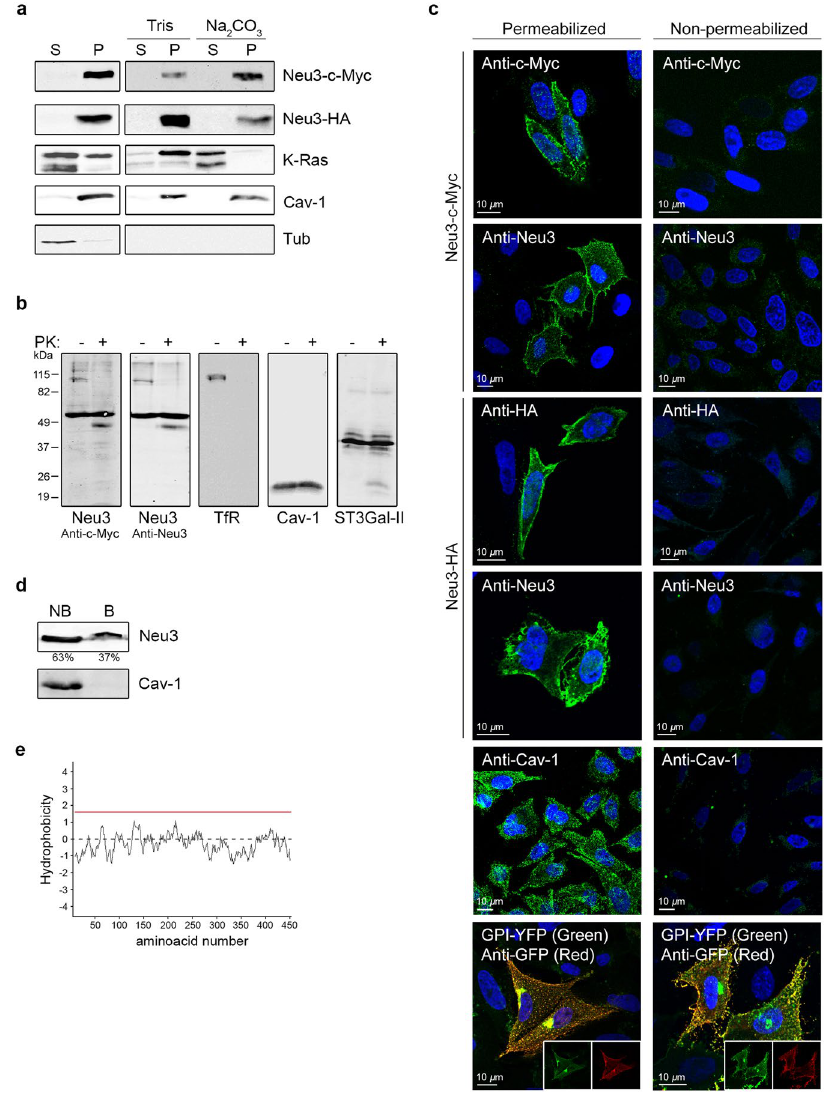
Figure 2. Neu3 behaves as an integral membrane protein. ( a ) Soluble (S, first lane) and membrane (P, second lane) fractions of NEU3 -transfected cells were obtained as described in Fig. 1a. The latter fraction was then incubated for 40 min on ice with Tris buffer (control) or Na 2 CO 3 at pH 11.5 in order to extract peripheral membrane proteins. After treatment, membranes were collected by ultracentrifugation, and membrane-bound (P, fourth and sixth lanes) and solubilized (S, third and fifth lanes) proteins were analyzed by Western blotting using anti-Neu3 antibody. K-Ras and Cav-1 were used as markers of an extractable and a non-extractable membrane protein, respectively. Tub was used as a marker of a soluble protein. ( b ) Intact NEU3 -transfected cells were treated with ( + ) or without ( − ) 100 µ g/ml proteinase K (PK) for 30 min at 37 °C. The remaining proteins were run on a SDS-PAGE gel and Western blotted with anti-c-Myc and anti-Neu3 antibodies. Transferrin Receptor (TfR) was used as a marker of a PK-accessible protein, whereas Cav-1 and sialyltransferase ST3Gal-II were used as markers of proteins not accessible to PK. The molecular masses in kDa of the standard proteins are shown on the left. ( c ) Antibody accessibility in permeabilized and non-permeabilized cells. The signal of the indicated antibodies were analyzed after fixation in cells treated with 0.1% saponin in PBS/BSA (permeabilized) or with PBS/BSA alone (non-permeabilized). Cav-1 was used as a marker of an inner membrane protein detected only after cell permeabilization, and GPI-YFP was used as a marker of an outer membrane protein accessible by antibody without permeabilization. Cells nuclei were stained blue with Hoechst dye. ( d ) Cell surface proteins exposed to the extracellular environment of NEU3 -transfected cells were biotinylated and isolated by streptavidin agarose pull-down. Biotinylated (B) and non-biotinylated (NB) fractions were analyzed by Western blotting. Endogenous marker Cav-1 was used as control of a membrane protein not exposed to the extracellular environment. Densitometric analysis indicating the percentage of Neu3 in each fraction is shown. ( e ) Kyte-Doolittle hydrophobicity plot for Neu3 sequence using a window size of 19. The red line corresponds to a hydrophobicity score of 1.6 and designates an empirical cutoff value for α -helix transmembrane segments of ~19 amino acids